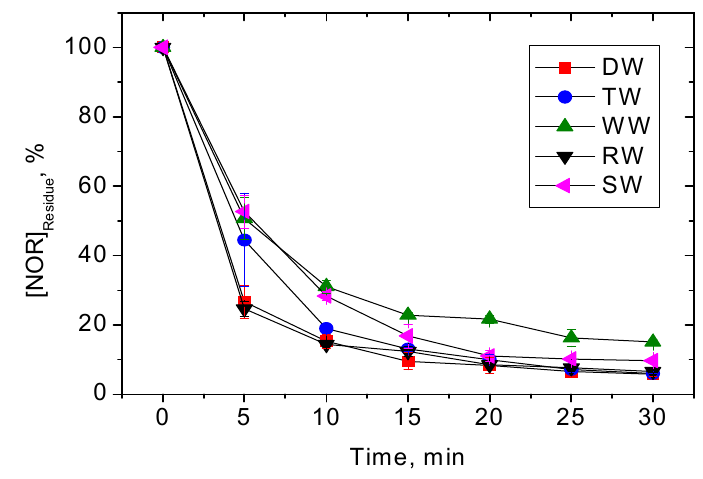
Figure 5. Degradation of NOR by the MW/UV process under different water matrices. (Experimental conditions: microwave power = 500 W, UV light intensity = 31.8 mW/cm 2 , maximum wavelength = 254 nm, [NOR] = 5 mg/L, DW—DI water, TW—Tap water, WW—Synthetic wastewater, RW—River water, SW—Sea water).